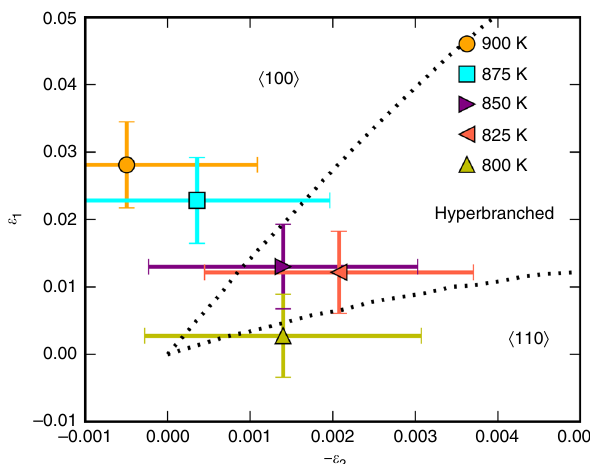
Fig. 3 Composition-dependent anisotropy parameters ϵ 1 and ϵ 2 . The boundaries (dashed lines) separating different dendritic growth regimes are reproduced from ref. 12 . The coloured points indicate the speci fi c temperatures at which equilibrium MD simulations were performed. As the temperature drops, the Sm composition in the liquid phase increases along the liquidus line while the solid phase remains pure Al as shown by the phase diagram in Fig. 2. The liquid composition increases from (cid:3) 1.7 at.% at 900 K to (cid:3) 3.9 at.% (875 K) to (cid:3) 6.1 at.% (850 K) to (cid:3) 7.4 at.% (825 K) to (cid:3) 8.3 at.% at 800 K. As the Sm content in the liquid increases (temperature drops), the interfacial anisotropy changes such that the expected dendritic growth mode shifts from h 100 i to hyper-branched to h 110 i . The error bars are calculated based on propagation of stiffness uncertainty, as described in Methods.